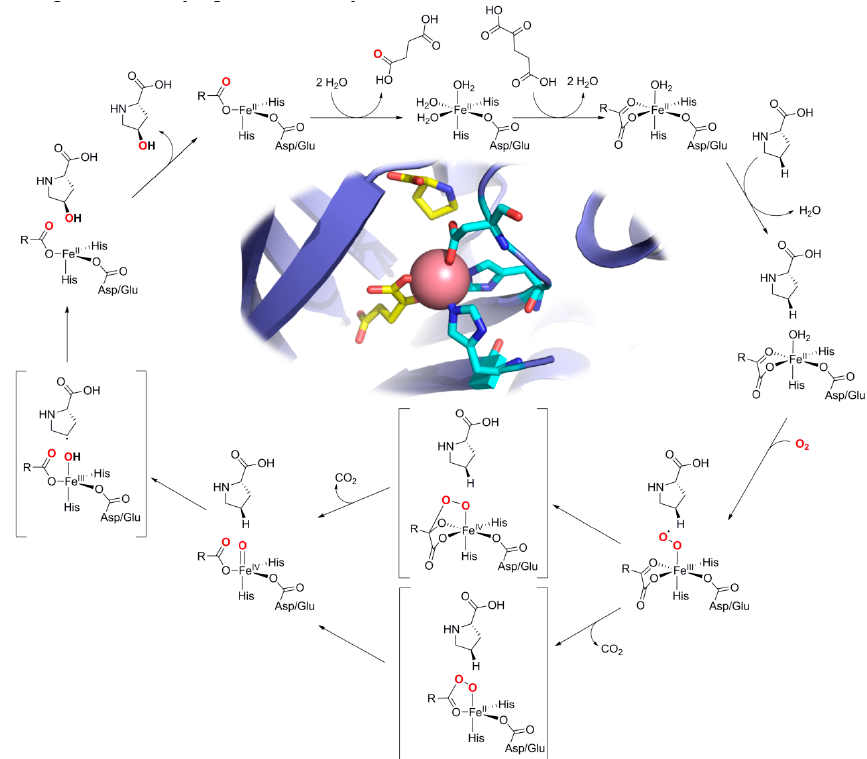
Figure 2. Proposed consensus mechanism of 2-oxoglutarate-dependent oxygenase (2OGX)-catalyzed hydroxylation using the example of proline derivatization. Inset: A magnified view of the active site of MlP4H (Protein Data Bank (PDB) access code 4P7W) in complex with Co 2+ (substituting for Fe(II) in crystallography), oxoglutarate (yellow), L -proline (yellow), and the coordinating His 106, Asp 108, and His 154 (cyan). Figure adapted from [2].